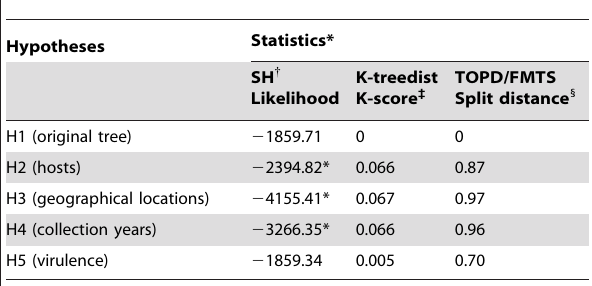
Table 1. Results of statistical tests of different evolutionary and ecological hypotheses that produce alternative tree topologies for the CTV p20 gene.